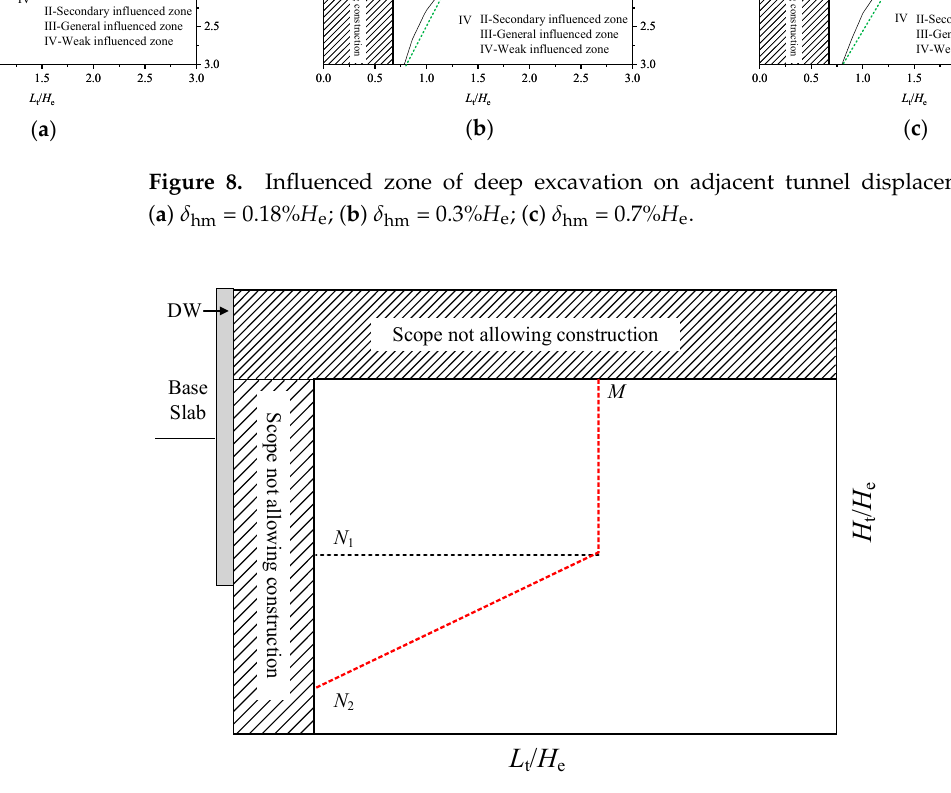
Figure 9. Schematic diagram of the influenced zone of deep excavation on adjacent tunnel displace-